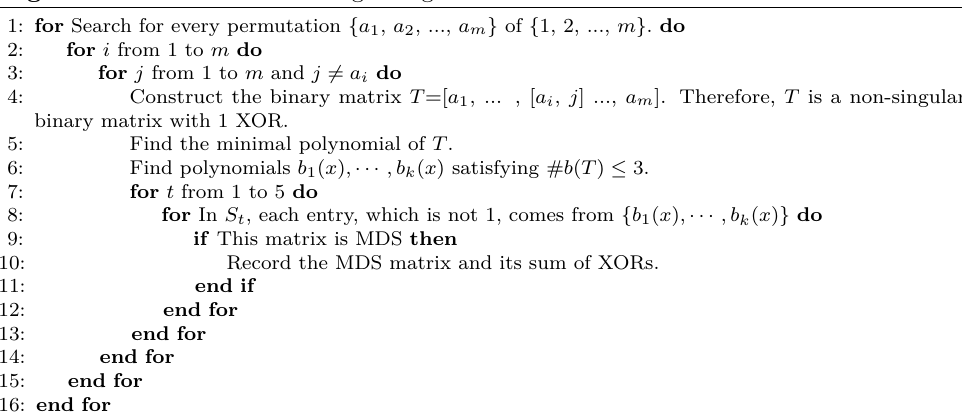
Algorithm 1 Construction of lightweight MDS